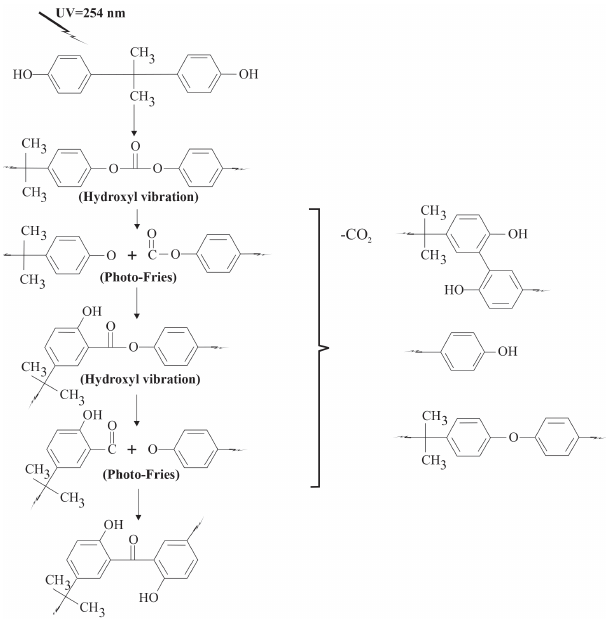
Figure 2. Photo-Fries rearrangement of BPA modified after Riva- ton